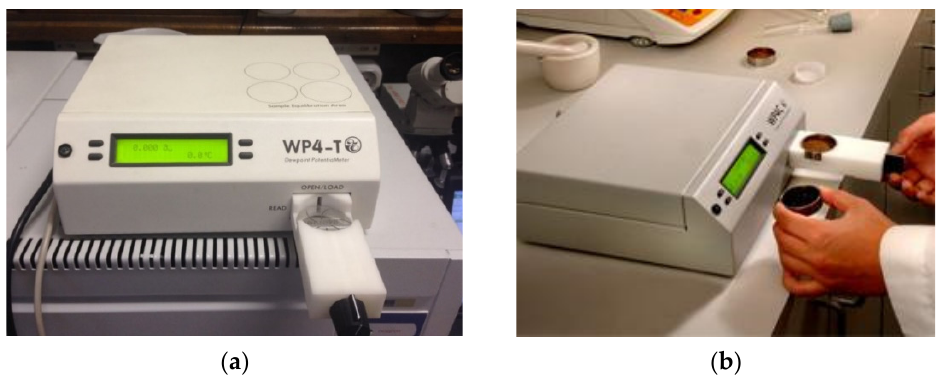
Figure 1. WP4-T ( a ) and WP4C ( b ) water potential meters.